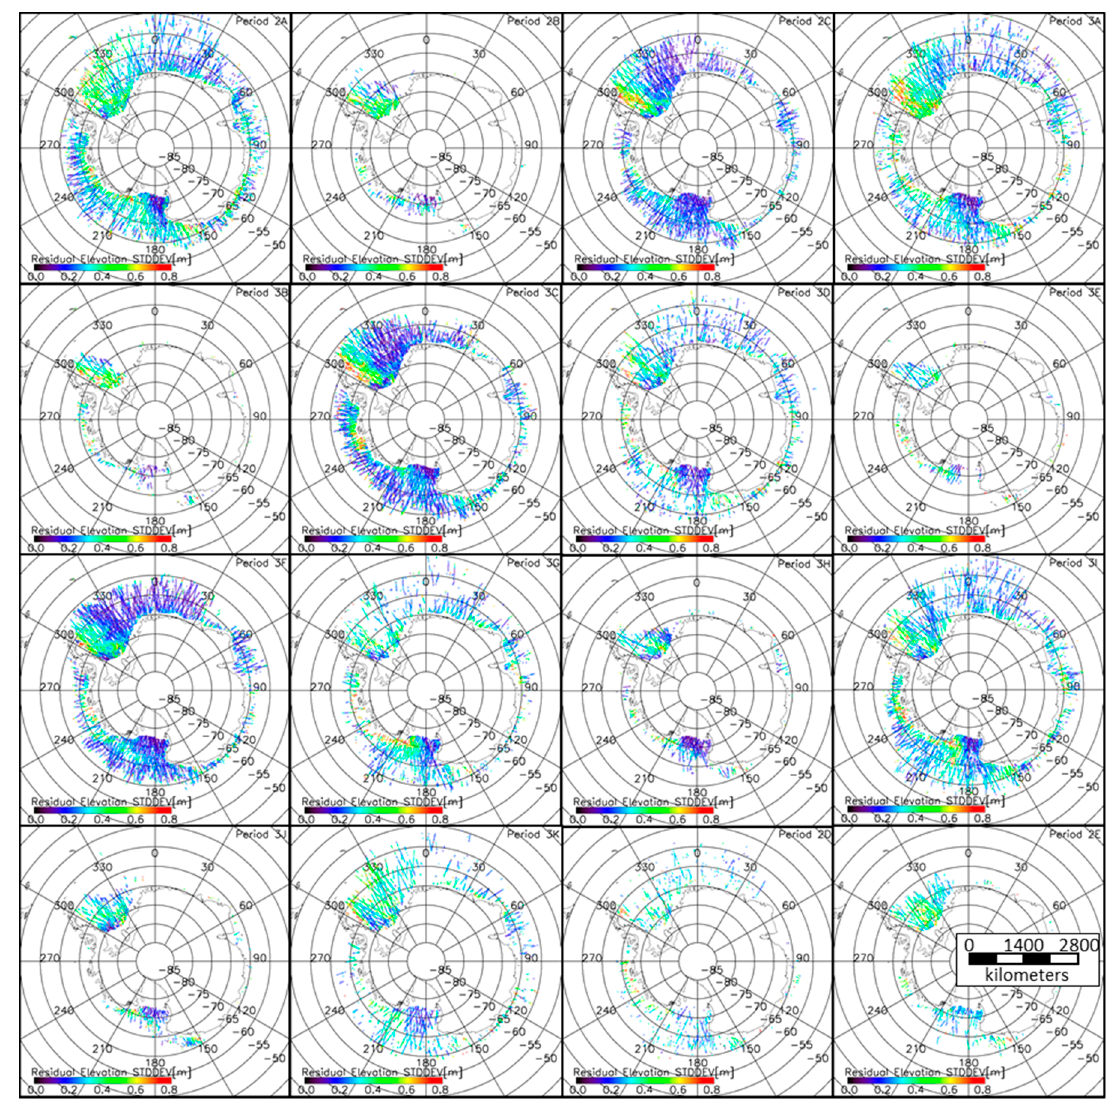
Figure 2. The maps of the ICESat residual elevation standard deviation used as the surface roughness proxy (see Section 3) for the measurement periods 2A: ON03 through 2E: MA09 (see Table